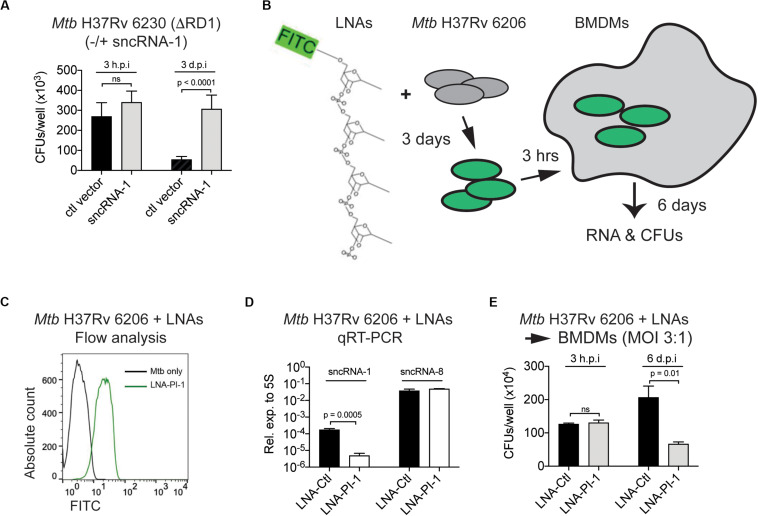
Locked nucleic acid power inhibitors antagonize sncRNA-1 functions in intracellular infections. (A)
Mtb H37Rv 6230 expressing control vector or sncRNA-1 expression vector were used to infect BMDM. BMDM was lysed in 0.05% SDS 3 h or 3 days post infection. Mtb H37Rv 6230 was plated on 7H10 agar plates with hygromycin and colony forming units were counted 2–3 days after plating. (B–E) Loss of function assay was developed to knockdown sncRNA-1 expression in Mtb H37Rv 6206. (B) Experimental design is shown. Exponentially growing Mtb H37Rv 6206 was incubated with LNA-PI targeting sncRNA-1 (LNA-PI-1) for 3 days. (C) Cells were fixed in 2% PFA and fluorescence intensity was analyzed with flow cytometry. (D) BMDMs were infected with Mtb H37Rv 6206 that had been incubated with LNA-PI-1 or LNA-Ctl. After 6 days, RNA was extracted, and sncRNA-1 and sncRNA-8 expression quantified with miRCURY LNATM quantitative miRNA PCR system. Statistical significance was determined with student t-test. (E) Infected BMDMs were lysed in 0.05% SDS at 3 h and 6 days post infection. The remaining Mtb H37Rv 6206 mycobacteria were plated on 7H10 agar plates with hygromycin. CFUs were counted around 3 weeks after plating. Statistical significance was determined with one-way ANOVA.